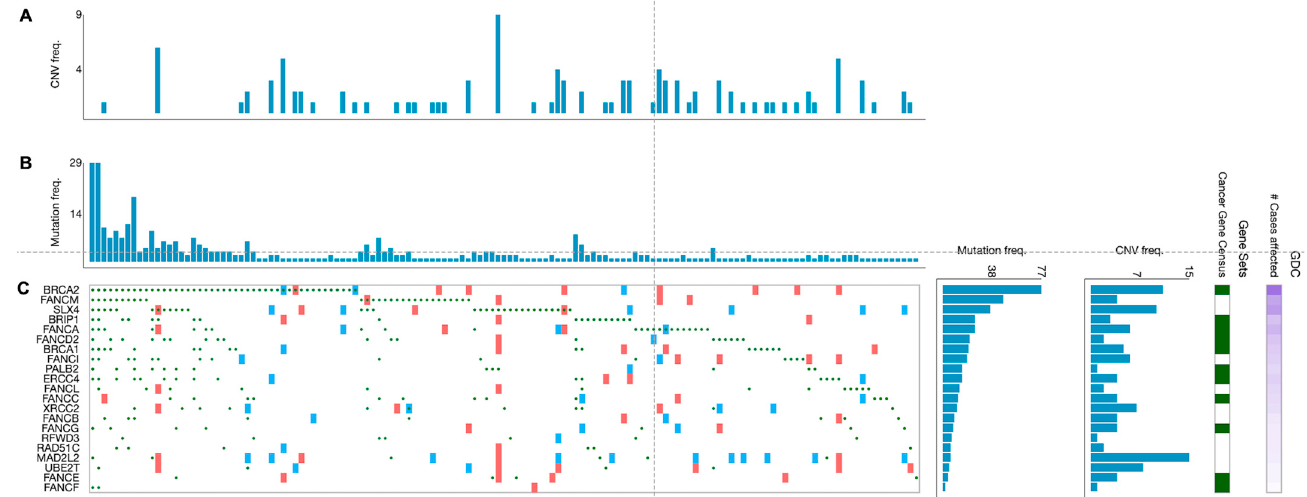
Figure 3. Genetic alterations of the FA genes in primary CRC specimens. Graphics show 139 primary CRC specimens displaying FANC gene mutations from a cohort of 395 cases. ( A ) Frequency of copy number variations and ( B ) frequency of mutations per tumor specimen. ( C ) Type of alterations per gene and per tumor specimen (green circles: missense, frameshift, start lost, stop lost, stop gained mutations; red squares: copy number variation (CNV) change, gain; blue squares: CNV change, loss). Data are from the TGCA program and have been generated from the GDC Data Portal [99].